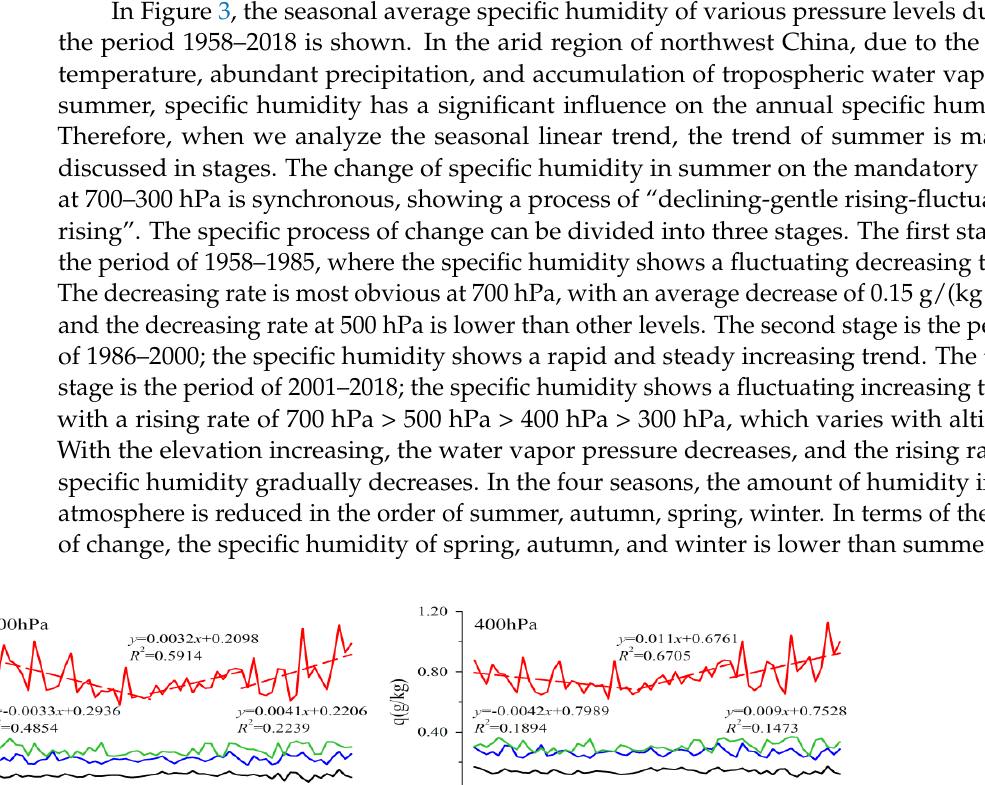
Figure 4. Level-month profile of annual specific humidity and monthly average temperature and precipitation during the period 1980–2018. Figure 5 shows well the vertical profiles of annual and seasonal specific humidity and linear trends of the study area during the period 1980–2018. The annual and seasonal